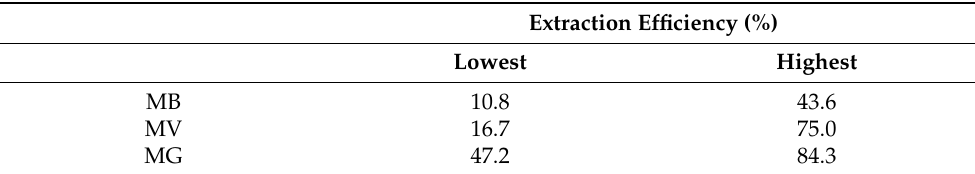
Figure 5. Dye extraction efficiencies after 5 min exposure of the dye solution with the C12:C6 mixture: ( a ) malachite green, ( b ) methyl violet, and ( c ) methylene blue at various dye concentrations (50 µ mol/L, 100 µ mol/L, 250 µ mol/L, and 500 µ mol/L) and extractant volume: 30 µ L (green circle), 60 µ L (red square), 120 µ L (yellow diamond), 300 µ L (black circle), and 600 µ L (blue square). The error bars are the standard deviations from the three trials. Table 4. Highest and lowest extraction efficiencies of the methylene blue (MB), methyl violet (MV), and malachite green (MG) dye solutions with the C12:C6 mixture at 5 min contact